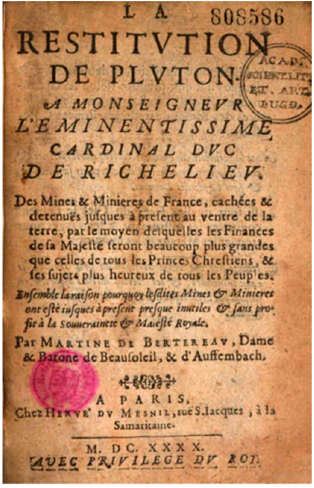
Figure 1. Martine de Bertereau’s La Restitution de Pluton [10].